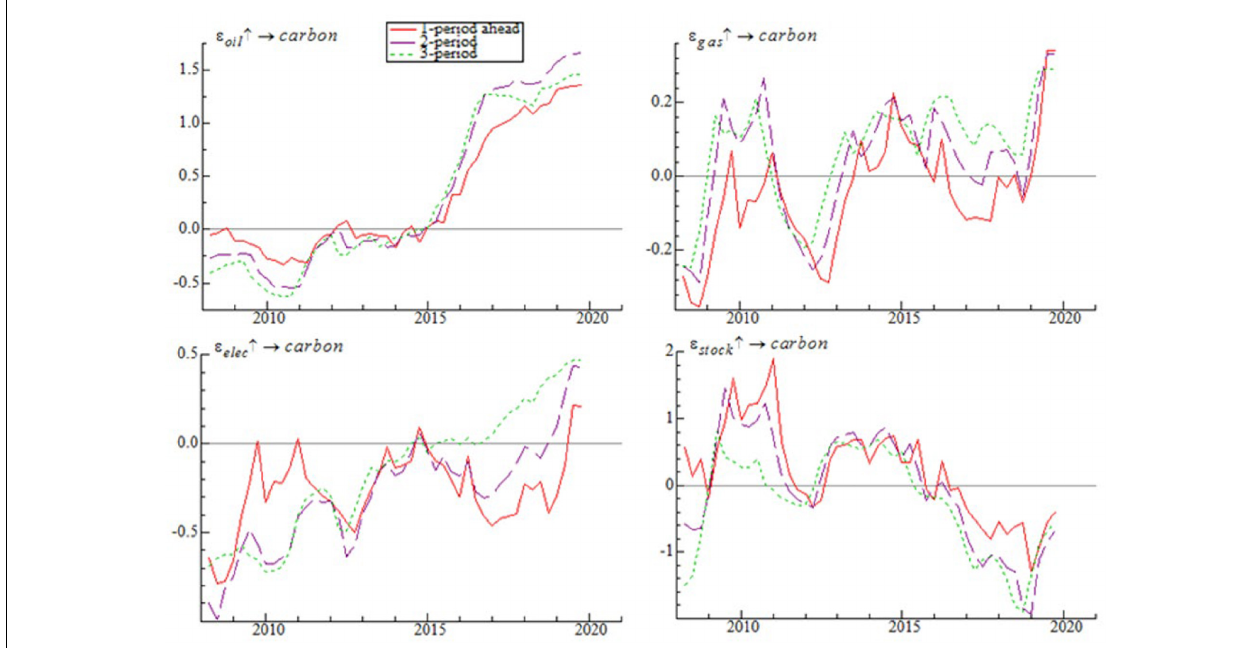
FIGURE 3 | Time impulse graph of the impact of carbon price on key price drivers.